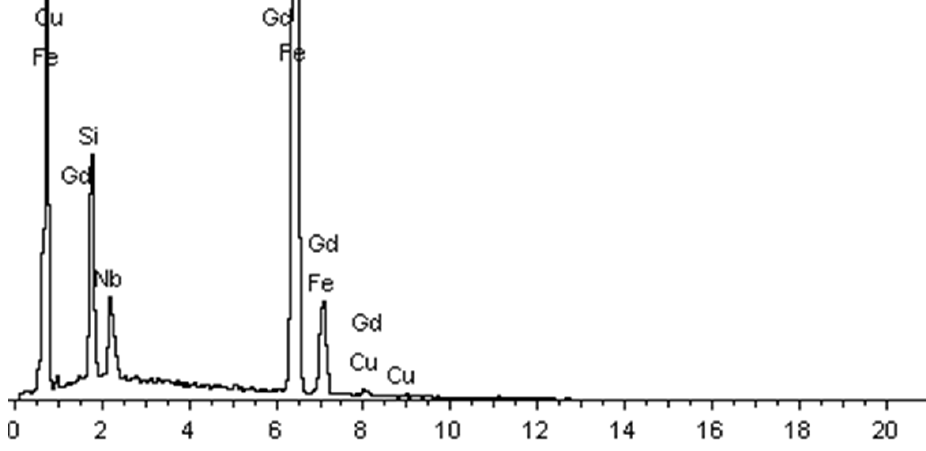
Figure 6. SEM and EDS of 1.0% Gd sample. Table 3. Element contents of 1.0% samples.